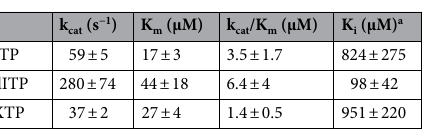
Table 1. Kinetic parameters for TbITPA. a Substrate inhibition